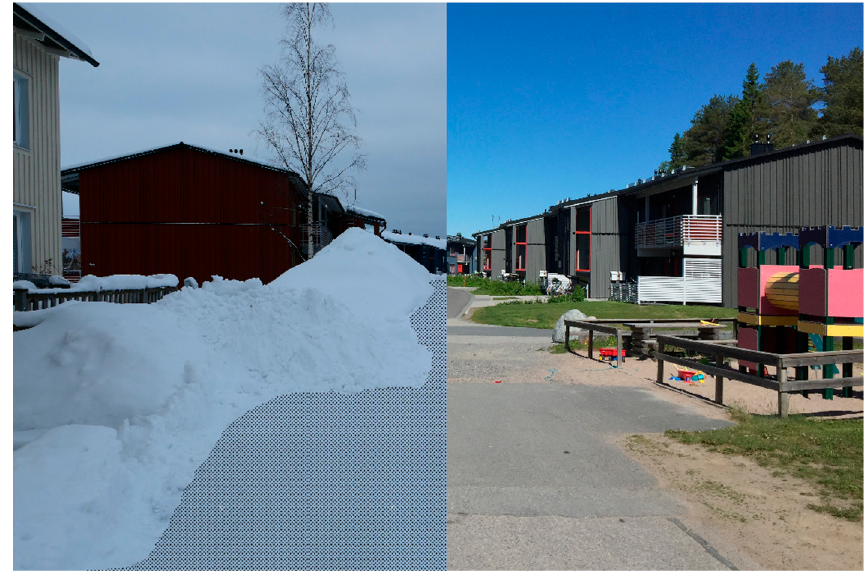
Figure 4. The same residential street as Figure 3, with the summer conditions shown on the right-hand side.